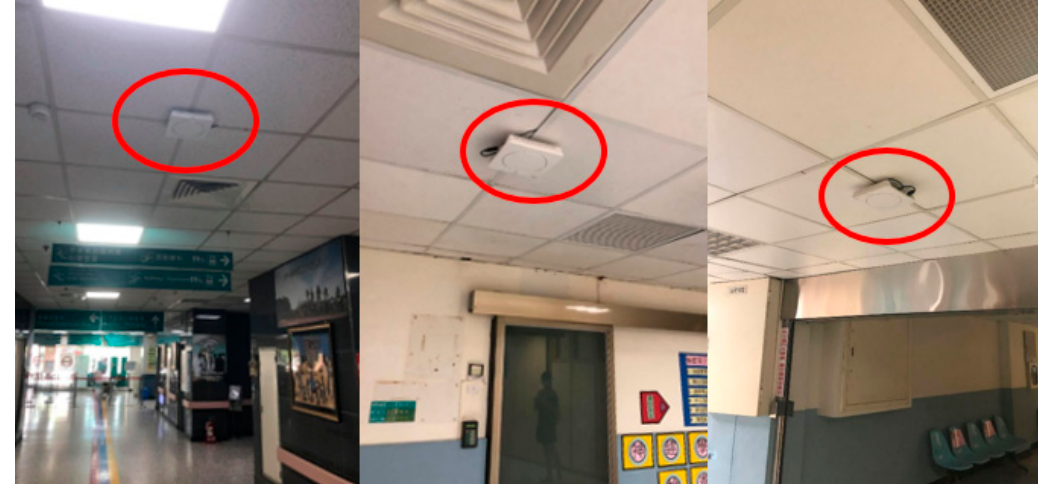
Figure 13. The deployment maps of Lbeacons in NTUH-Yunlin.